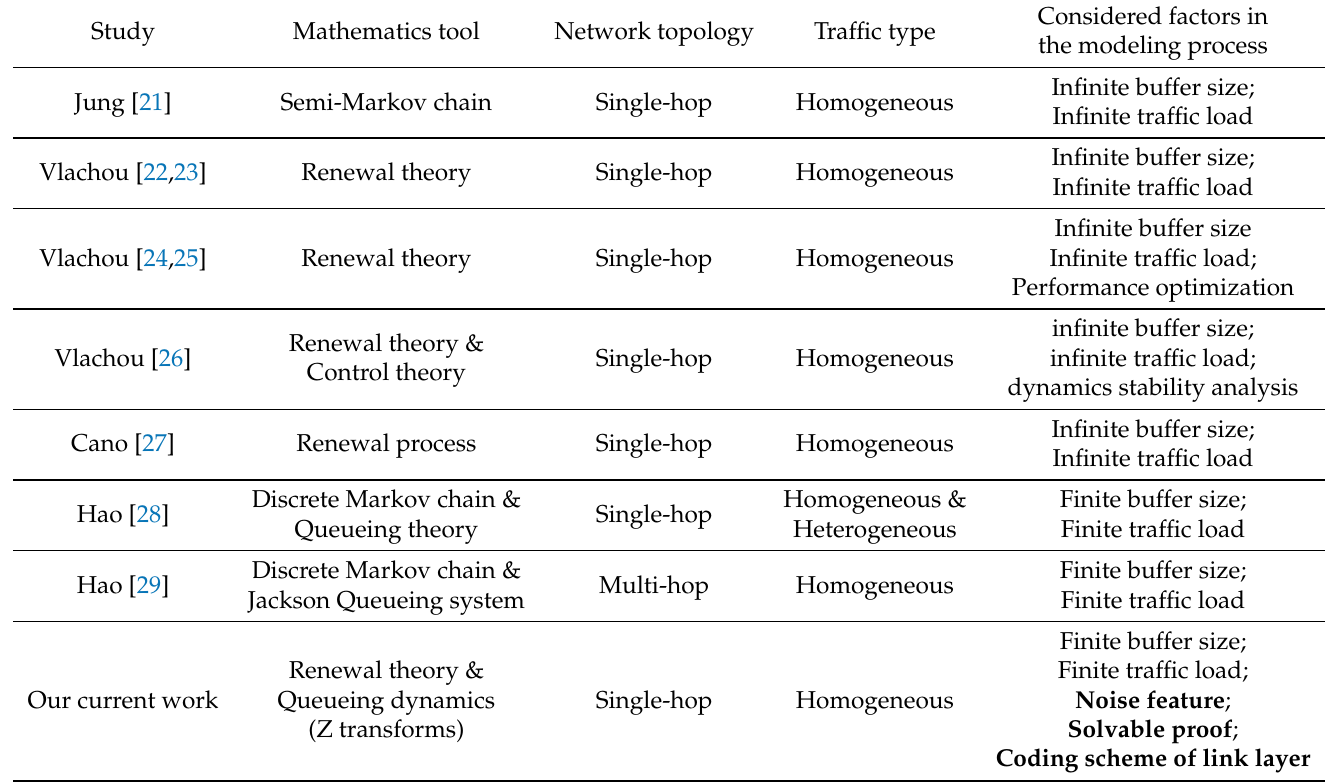
Table 2. Summary of the works for IEEE 1901 protocol analysis (including our current